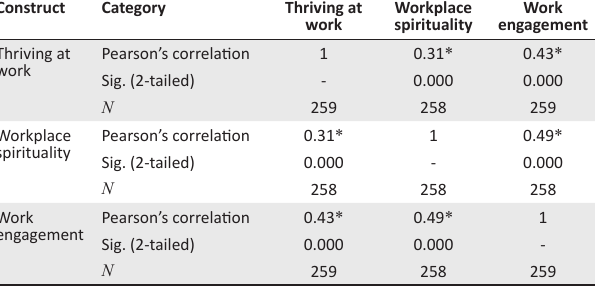
TABLE 3: Pearson’s product-moment correlation results for thriving at work, workplace spirituality and work engagement ( n = 259). Construct